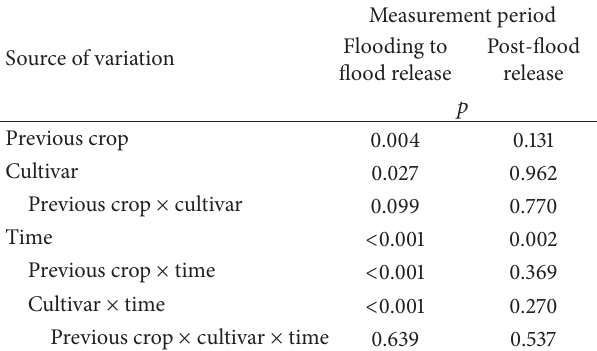
Figure 2: Methane fluxes over time throughout the flooded por- tion of the 2013 growing season from CLXL745, Cheniere, and Taggart averaged across previous crop treatment at the Northeast Research and Extension Center in Keiser, Arkansas. The vertical dashed lines represent panicle differentiation (PD) and 50% heading (HDG) dates for CLXL745, Cheniere, and Taggart at 54, 58, and 61 days after flooding, respectively. Flood release occurred in 83 days after flooding. Least significant difference for the same cultivar = 0.241mg CH 4 -Cm −2 hr −1 and for different cultivars = 0.307 mgCH 4 -Cm −2 hr −1 . Error bars indicate standard errors for the treatment means ( 𝑁 = 8